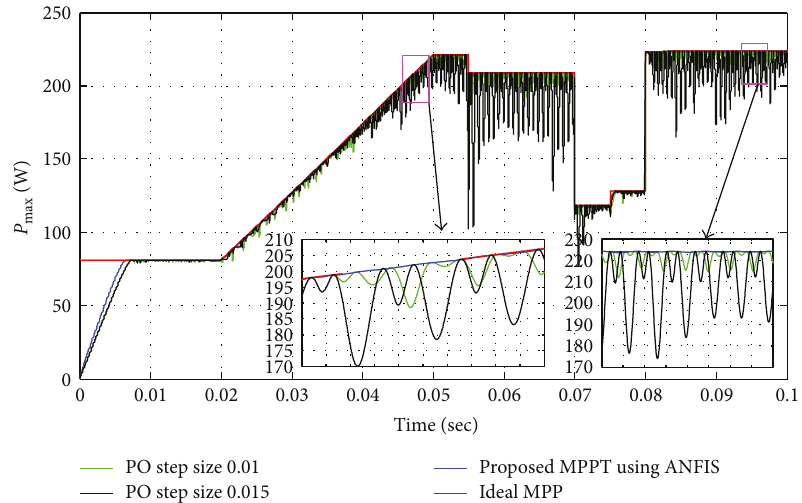
Figure 17: MPPT performance at dynamic weather conditions.